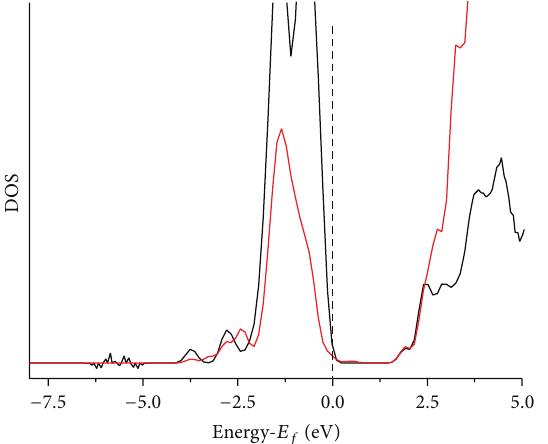
Figure 6: DOS of the Ni doped BaO(100) surface. Only region near to the Fermi level is plotted for a better overview. Total DOS in black line and the projected DOS of the 𝑑 orbital of the surface Ba atom in red